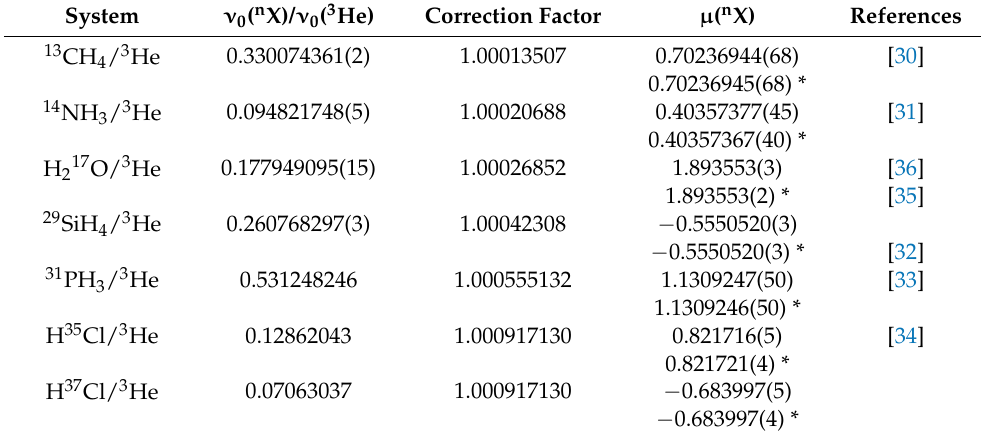
Table 3. NMR parameters in simple hydrides for the calculation of the nuclear magnetic moments of 13 C, 14 N, 17 O, 29 Si, 31 P, and 35/37 Cl nuclei from gas-phase